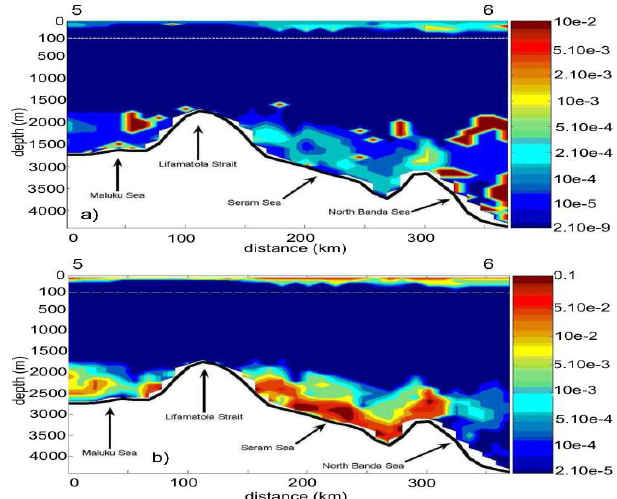
Fig. 2. Sections of (a) q 2 (m 2 s − 2 ) and (b) K M (m 2 s − 1 ) through the sill in the North Sangihe Ridge. Locations of points 1 and 2 at the top of the figures are given in Fig. 1.